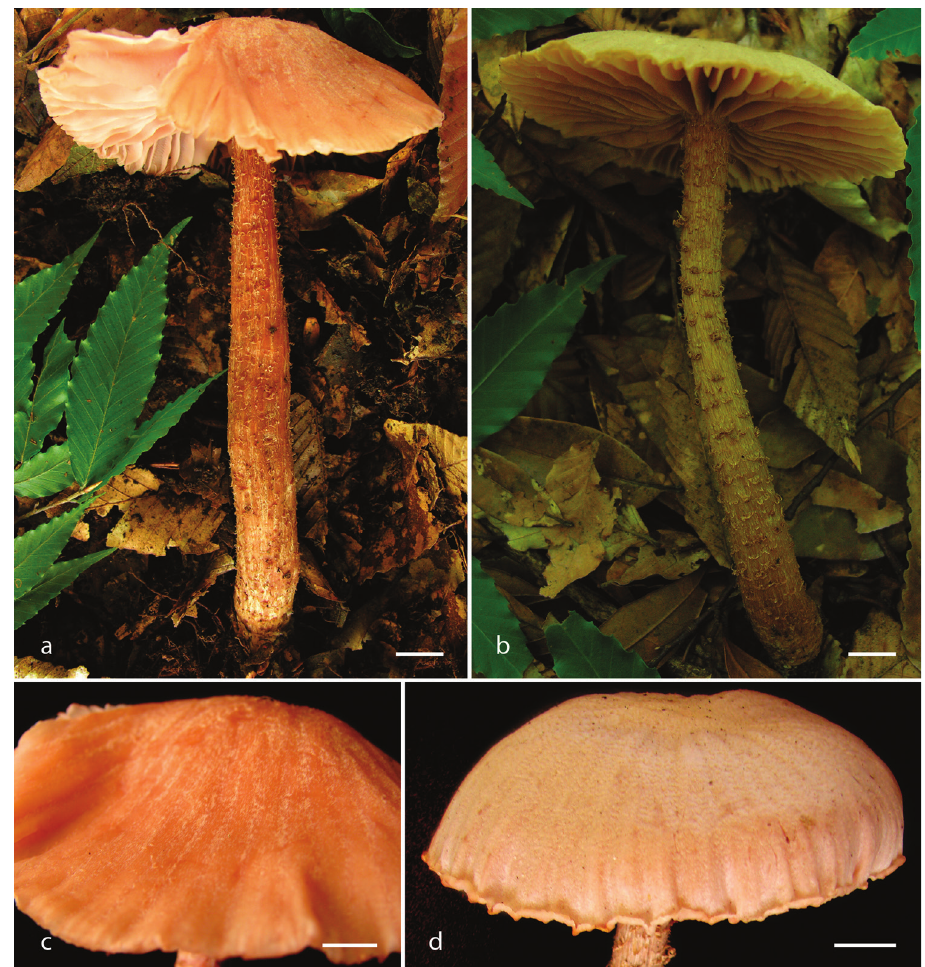
Figure 2. Laccaria squarrosa , basidiomes. a, b habit c, d pileus surface details a, c DM 121 b DM 63 (holotype) d DM 93. Scale bars: 10